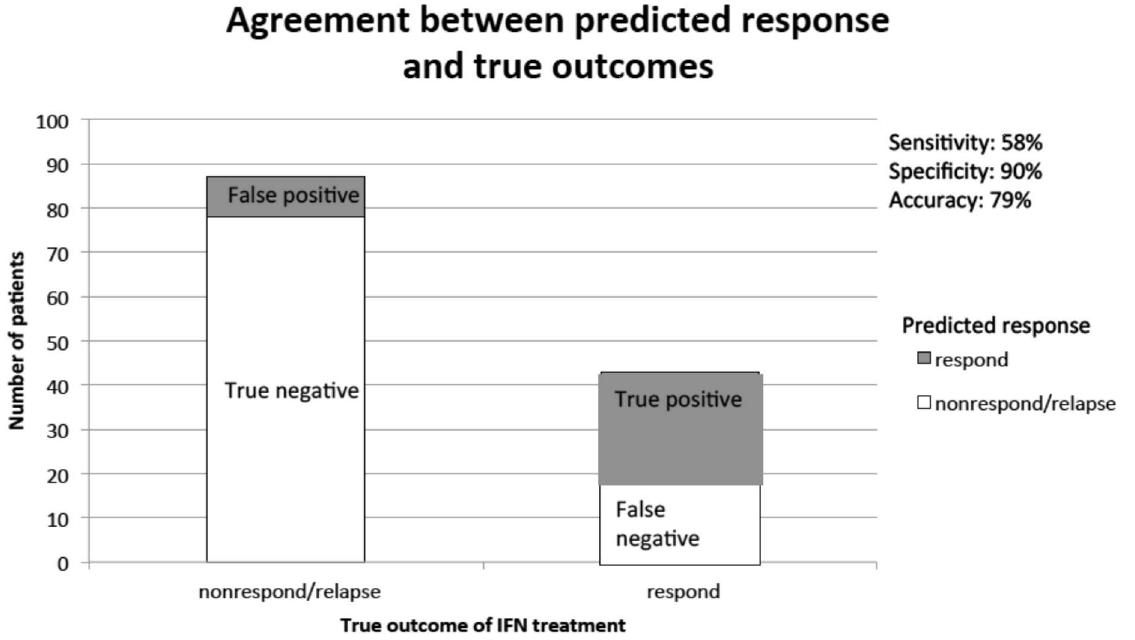
Figure 6. The distribution of predicted probability of therapeutic response (with relapsers included). We found that those who actually responded to IFN-ribavirin treatment had higher predicted probabilities of response in the